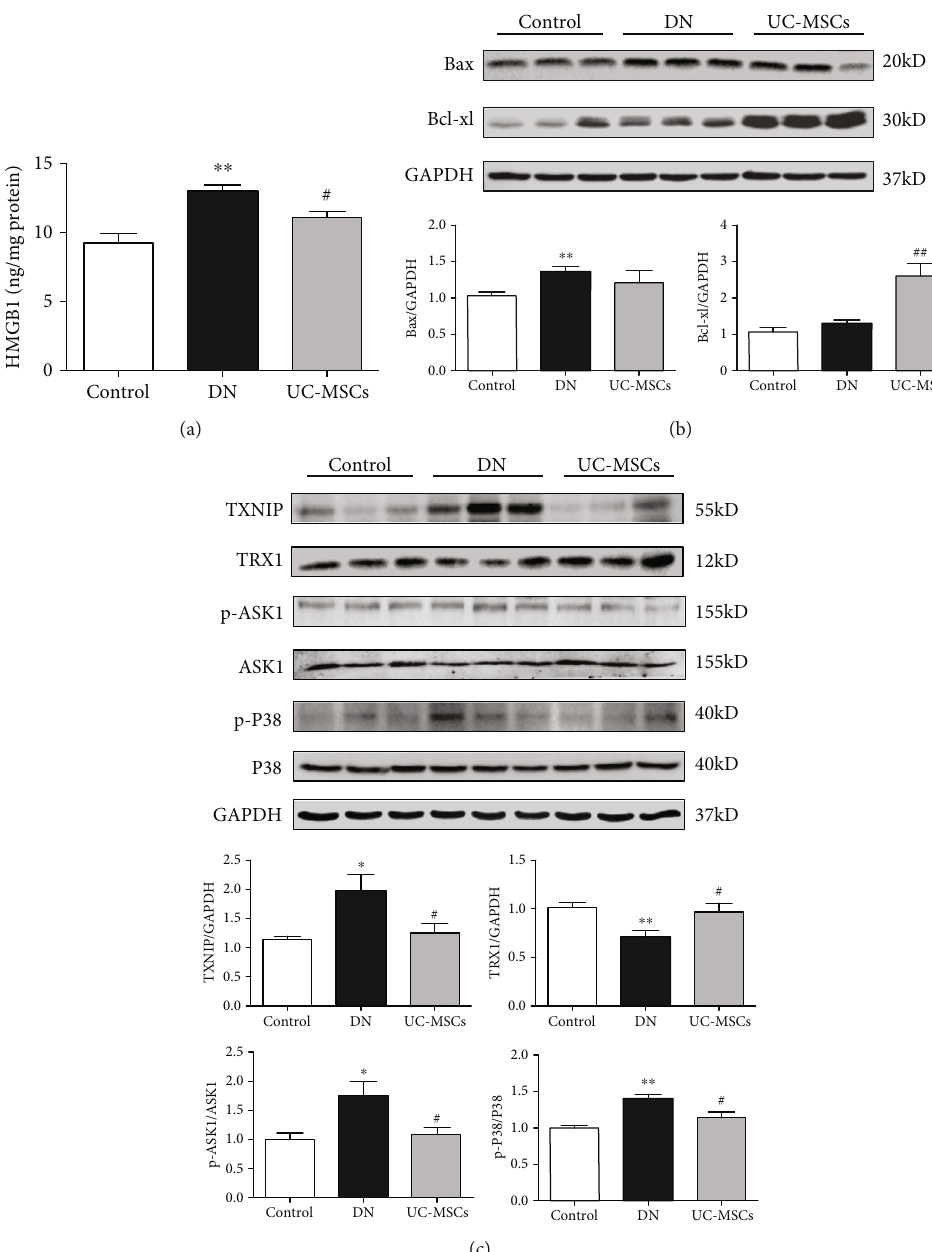
Figure 5: Apoptosis-related proteins were examined in the kidney of rats. (a) Concentration of HMGB1 in renal tissue was determined by ELISA. (b, c) Expression of Bax, Bcl-xl, TXNIP, TRX1, p-ASK1, ASK1, p-P38, and P38 was detected by the Western blot assay. GAPDH was used as the internal control ( n = 4~5 , ∗∗ p < 0 : 01 versus control group, ∗ p < 0 : 05 versus control group, ## p < 0 : 01 versus DN group, and # p < 0 : 05 versus DN